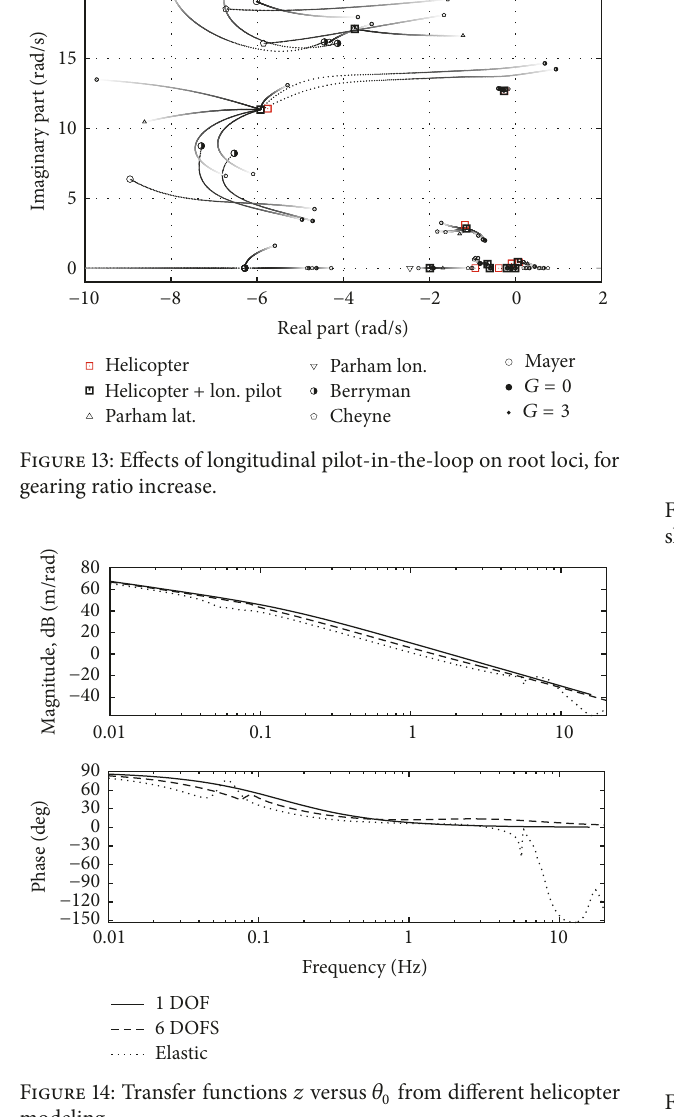
Figure 16: Influenceof helicopterdynamic modeling on active pilot in the